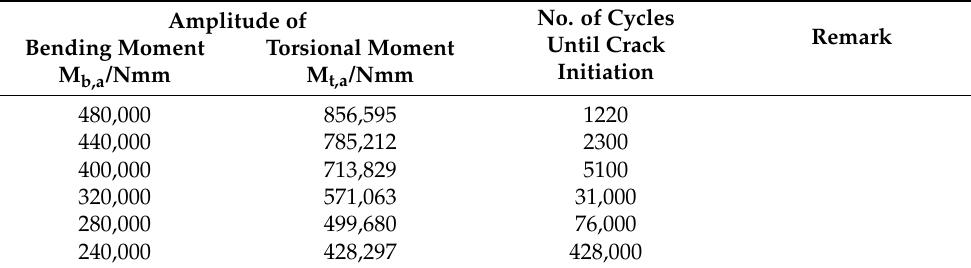
Table A3. Test results for proportional combination of bending and torsion ( τ xy,a / σ x,a = 0.75).